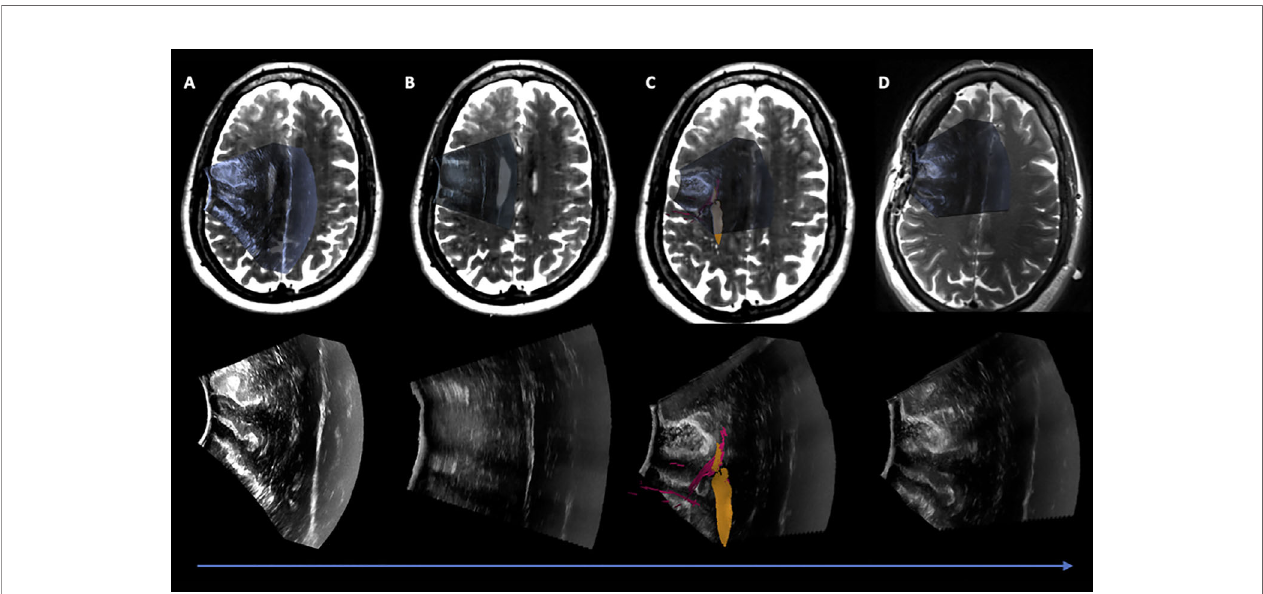
FIGURE 3 | Case 1 Post hoc manually aligned preoperative axial T2-weighted imaging with (A) iUS-1, (B) iUS-2, (C) iUS-3 with right Corticospinal Tract (yellow) and Frontal Aslant Tract (red), and (D) iMRI axial T2-weighted imaging manually aligned with iUS-3. On D it is possible to observe a gross total resection on iUS and con fi rmed by